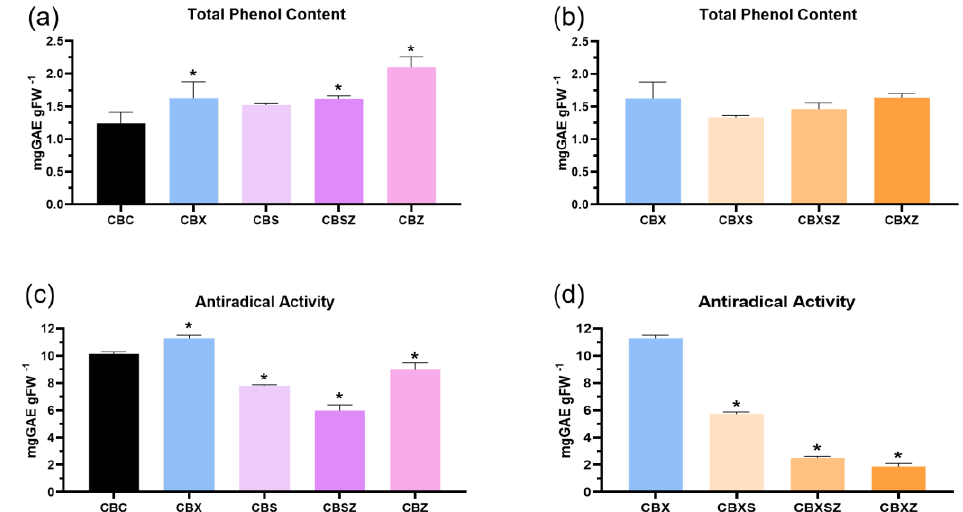
Figure 5. Total phenol content ( a , b ) and antiradical activity ( c , d ) of tomato leaves 12 days after X. euvesicatoria infection and 10 days after treatments. ( a , c ) represent the levels on uninfected/treated groups (CBS; CBSZ; CBZ) and infected/untreated control (CBX) compared to the uninfected/untreated control (CBC). ( b , d ) represent levels on infected/treated groups (CBXS; CBXSZ; CBXZ) compared to the infected/untreated control (CBX). Values are presented as mean ± standard deviation (n = 3). All means marked with an asterisk are statistically different of the respective control according to the Dunnett comparison test ( p < 0.05).